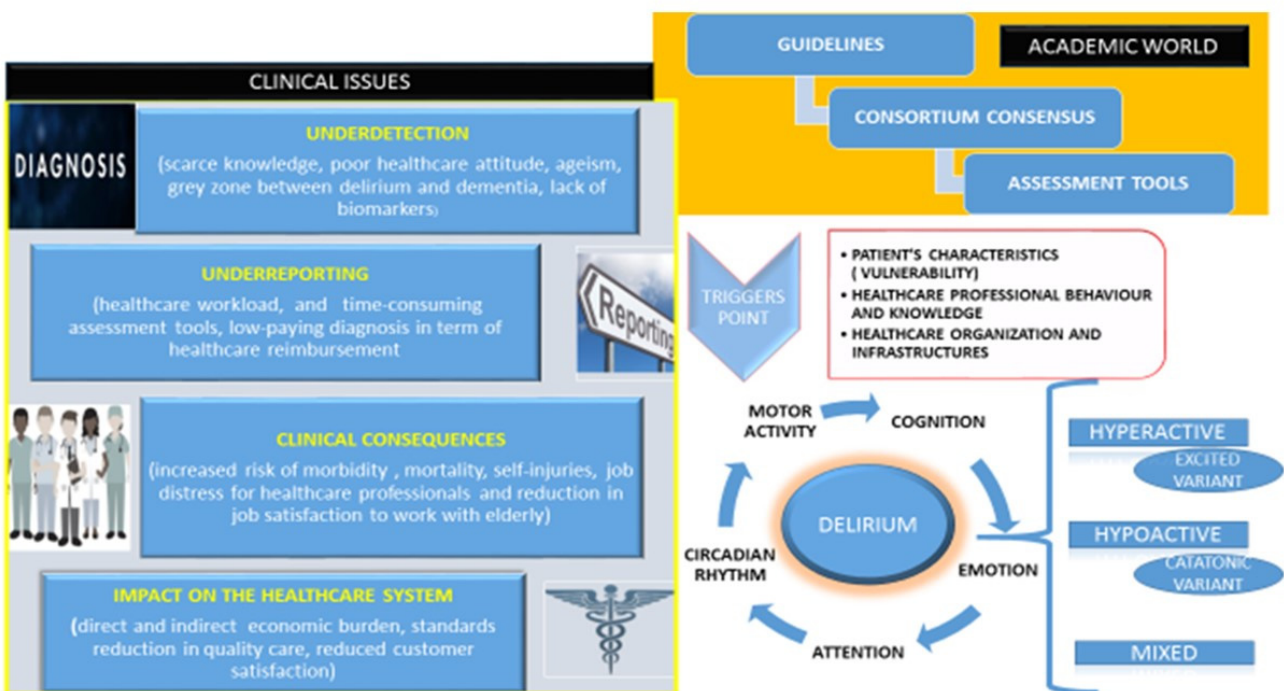
Figure 1. The wall of clinical issues about delirium. Phenomenologically, delirium shows five features: cognitive deficits, attentional deficits, circadian rhythm dysregulation, emotional dysregulation, and psychomotor dysregulation. Phenotypically, there are at least five types of delirium. Healthcare organizations may exacerbate the trigger point’s load with clinical issues that persist despite the increased academic knowledge on this hot topic.